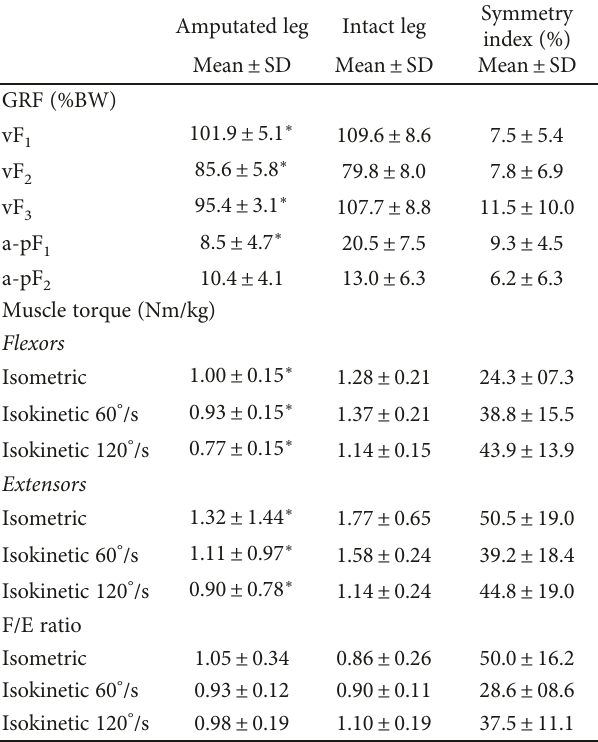
Table 3: Correlation coe ffi cients between the symmetry index for ground reaction forces and symmetry index for hip fl exor and extensor peak muscle torques for the amputated limb statically and dynamically.